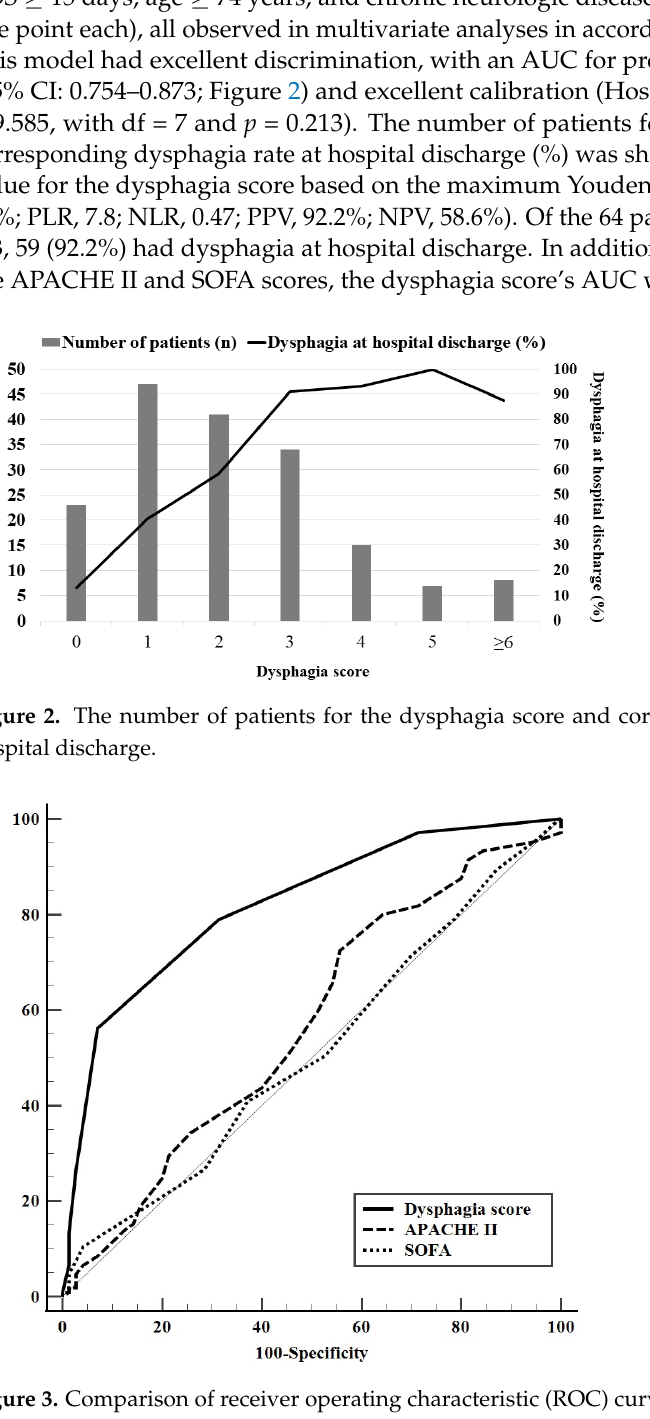
Figure 3. Comparison of receiver operating characteristic (ROC) curves for dysphagia score, Acute Physiology and Chronic Health Evaluation (APACHE) II score, and Sequential Organ Failure Assessment (SOFA) score for predicting dysphagia at hospital discharge. For all patients, the areas under the ROC curves (AUCs) for dysphagia score, APACHE II score, and SOFA score were 0.819 (95% confidence interval [CI]: 0.754–0.873; p < 0.001), 0.568 (95% CI: 0.491–0.643; p = 129), and 0.511 (95% CI: 0.435–0.587; p = 0.891), respectively. The AUC for dysphagia score was significantly higher than the AUCs for the other two scores ( p < 0.001 each).